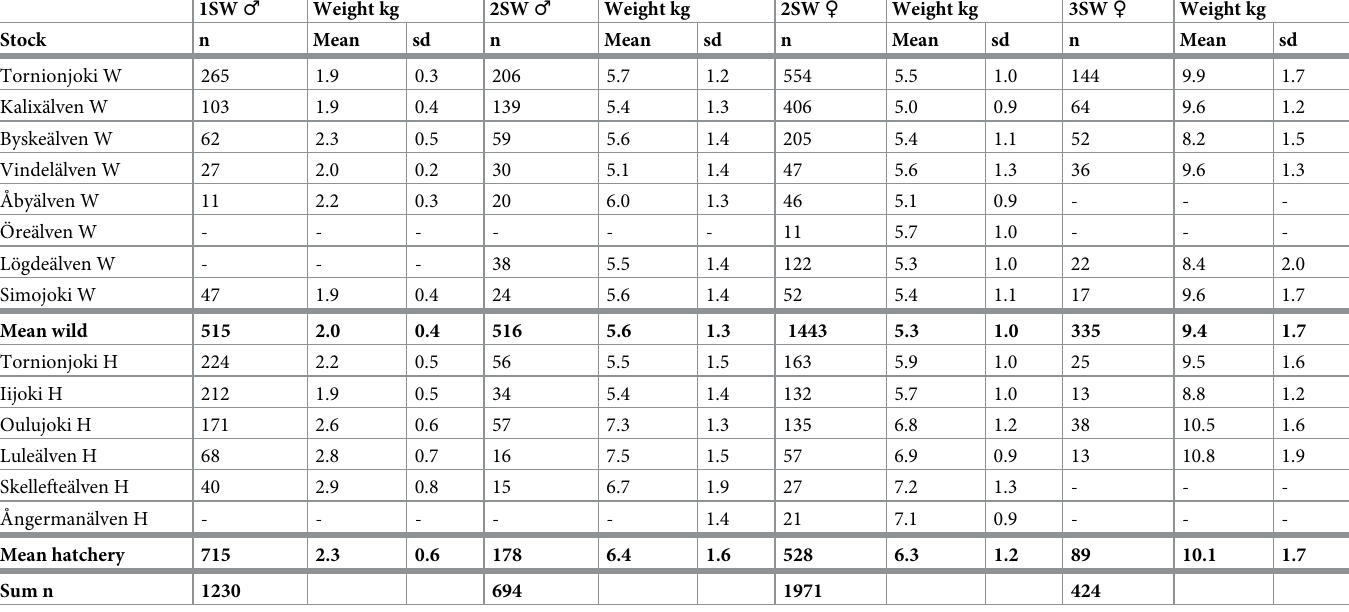
Table 5. Mean weight of mature Atlantic salmon catch fish from different rivers in the Bothnian Sea in 2000–2013. 1SW